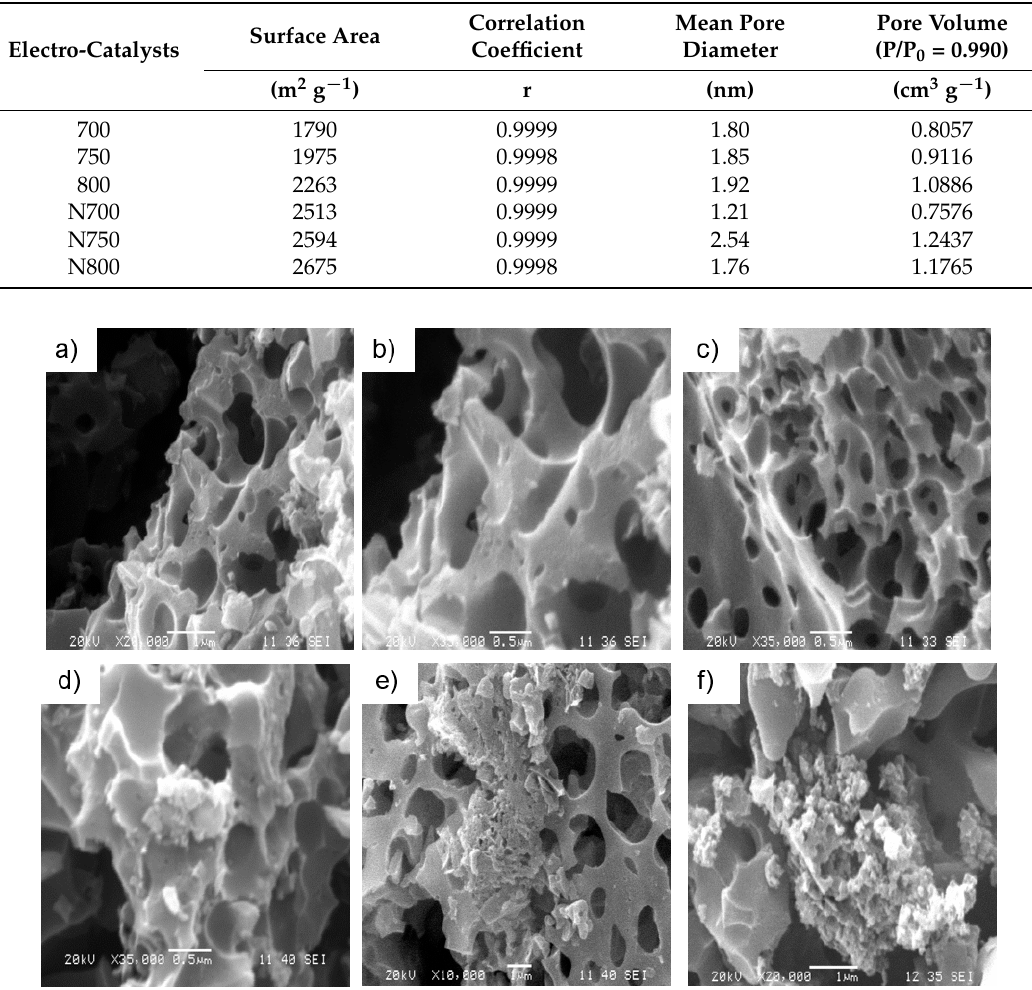
Figure 2. SEM images for electrocatalysts ( a ) 700; ( b ) 750; ( c ) 800; ( d ) N700; ( e ) N750, and ( f ) N800.